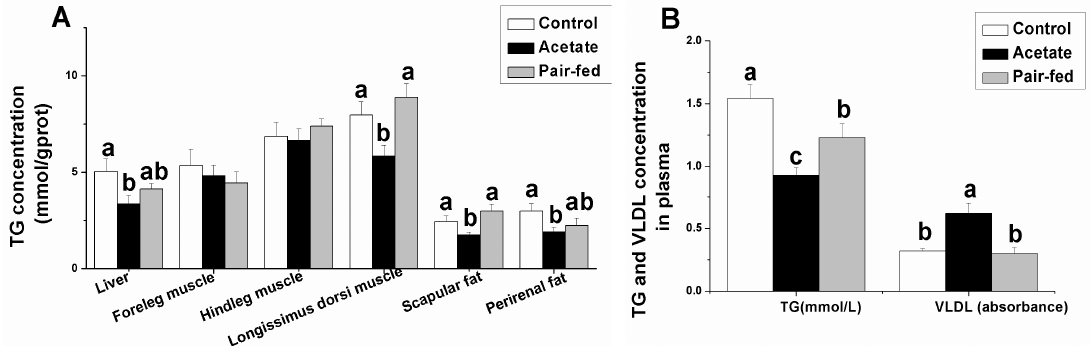
Figure 2. The effect of acetate treatment on TG concentration in tissue (mmol/gprot) ( A ) and TG (mmol/L) and VLDL concentration (absorbance) in plasma ( B ). a, b, c: means with different superscripts are significantly different ( p < 0.05). (Abbreviations: TG, triglycerides; VLDL, very low-density lipoprotein.).